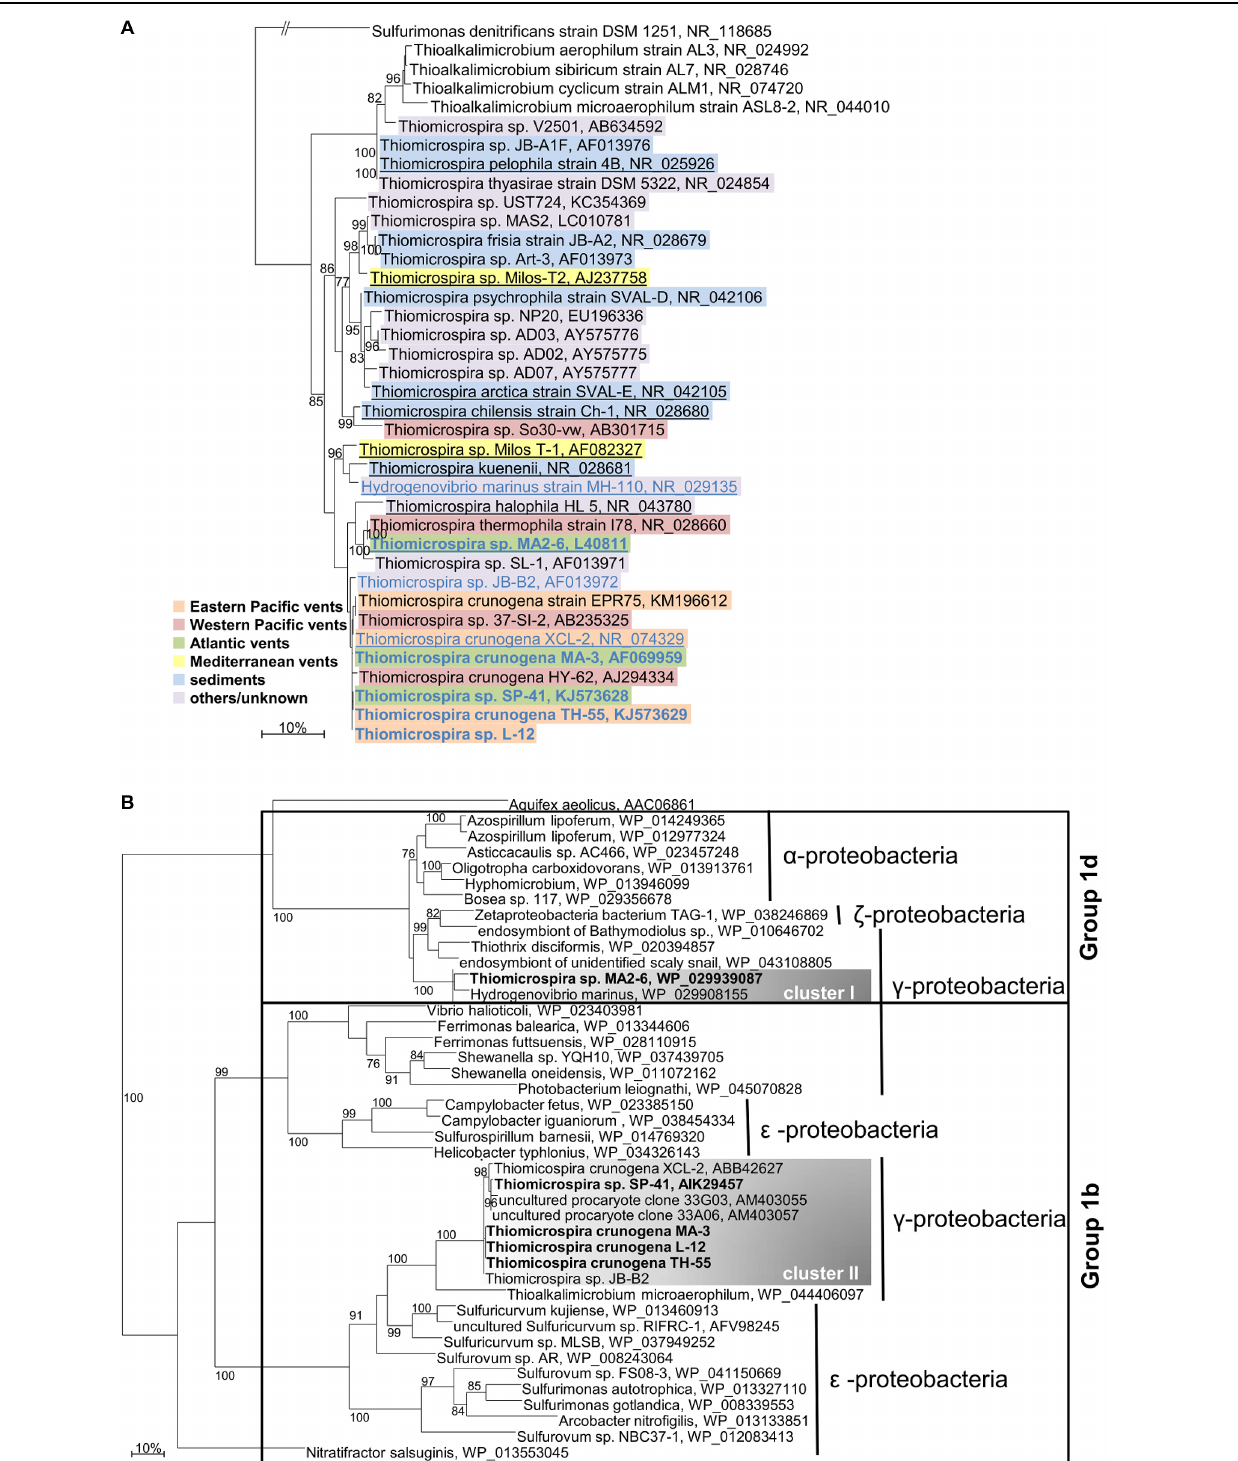
FIGURE 1 | Phylogenetic relationship of Thiomicrospira species. (A) 16S rRNA genes. Thiomicrospira species are color-coded according to their isolation source. Species that are underlined indicate that genomic sequence data is available. Species for which a hynL gene is known are written in blue, those which consumed hydrogen in our experiments are written in bold. (B) [NiFe]-hydrogenase large subunit genes ( hynL) . Species which consumed hydrogen in our experiments are written in bold. Only bootstrap values ≥ 75 are given. The scale bar represents the expected number of changes per (A) nucleotide and (B) amino acid. Classification in (B) is according to Greening et al. (2015). Aquifex aeolicus’ [NiFe]-hydrogenase belongs to group 1e.